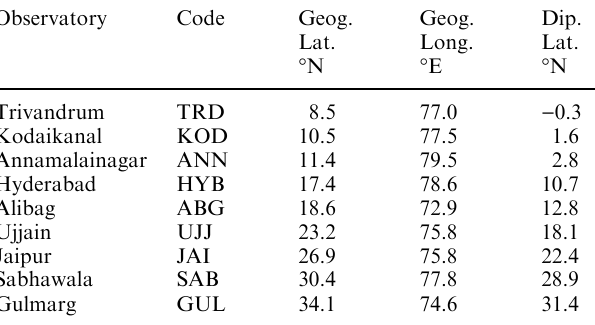
Table 1 List of geomagnetic observatories in India Observatory Code